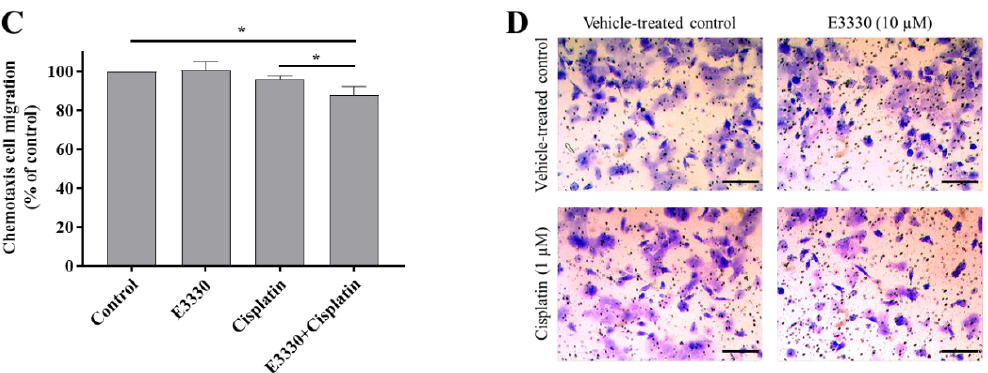
Figure 7. E3330 effect on collective and chemotactic migration of H1975 cells exposed to cisplatin. Collective cell migration was evaluated by the wound-healing assay ( A ) and chemotaxis was measured using a transwell assay ( C ). Representative microscopy images of the wound-healing assay (40 × , B ) and the chemotaxis assay (migrating cells stained with crystal violet—100 × , D ). Scale bars = 200 µ m. Values for the wound-healing assay represent mean ± SD ( n = 3) and are expressed as percentage of wound closure, calculated relative to the initial width; * p < 0.05 and ** p < 0.01 (Student’s t -test). Values for the chemotaxis assay represent mean ± SD ( n = 3) and are expressed as percentages relative to vehicle-treated control cells; * p < 0.05 (Student’s t -test).